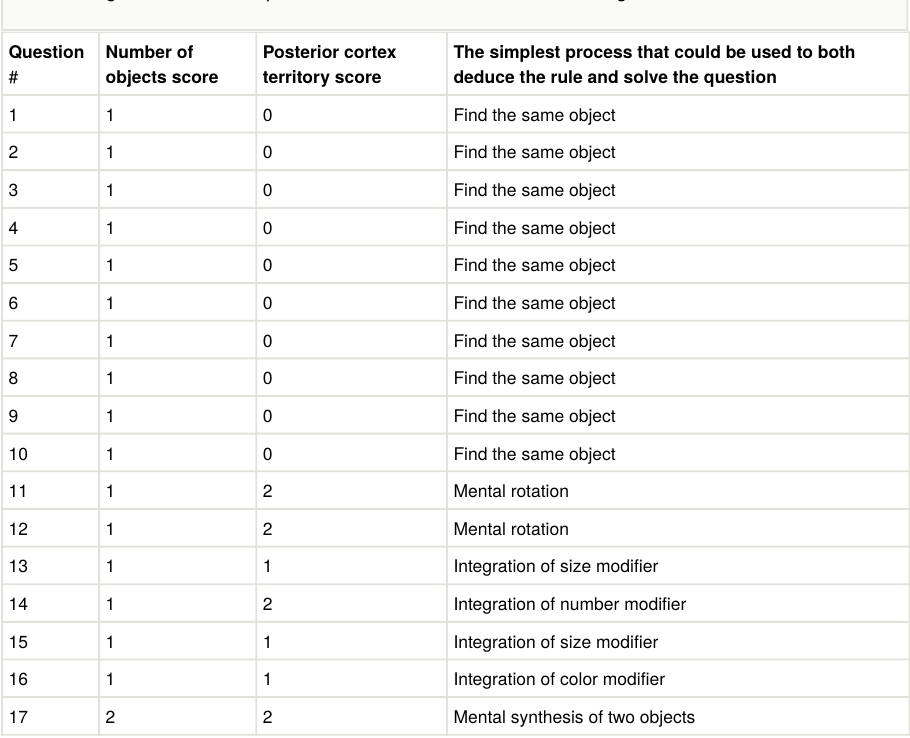
Panel assignment of mental processes for WISC-V, Matrix